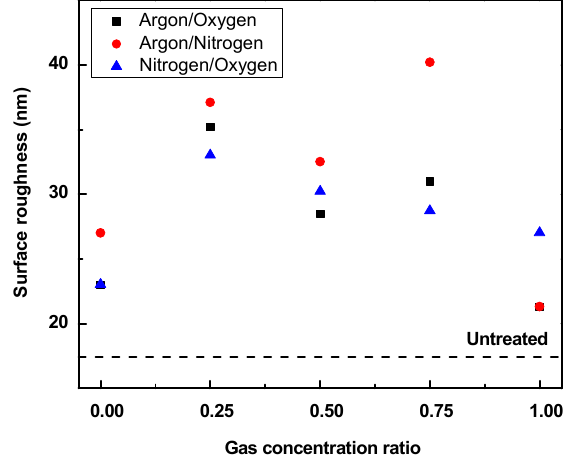
Figure 23. Surface roughness plasma treated LDPE using different gas mixtures ratio.